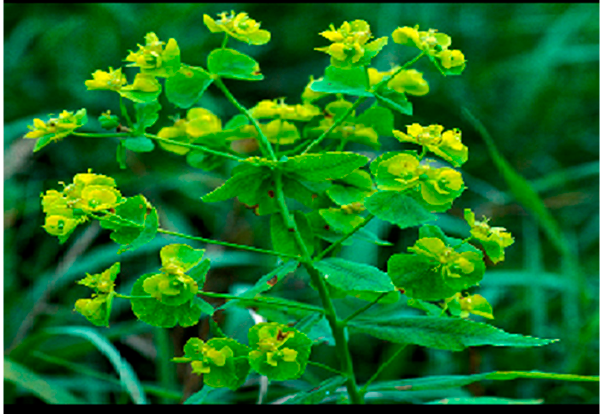
Figure 1. Image of Euphorbia esula L.